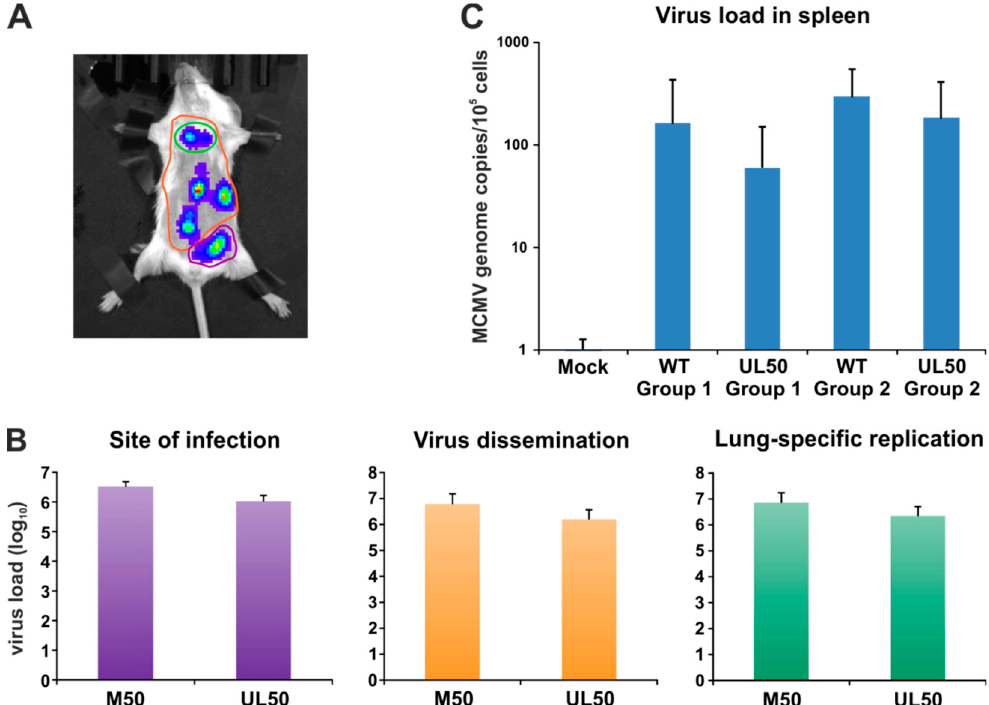
Figure 7. Quantitation of primary and secondary replication. ( A ) Specific regions of interest were selected for site of infection (purple), virus dissemination (orange) and lung-specific replication (green). ( B ) Evaluation was performed using Living Image 4.5. ( C ) Viral genome equivalents in the spleen were determined by murine IE1-specific quantitative real-time PCR.